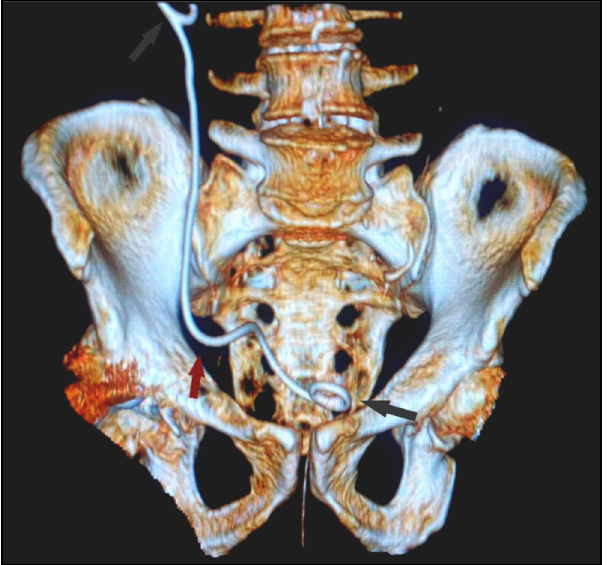
Figure 1. 3D reconstruction of the postoperative pelvic CT scan with urography in a 75-year-old male with native kidneys and a right JJ Stent placement (curled ends highlighted by gray arrows). Bulging of the inferior 1/3 of the ureter (red arrow) towards the inguinal canal.